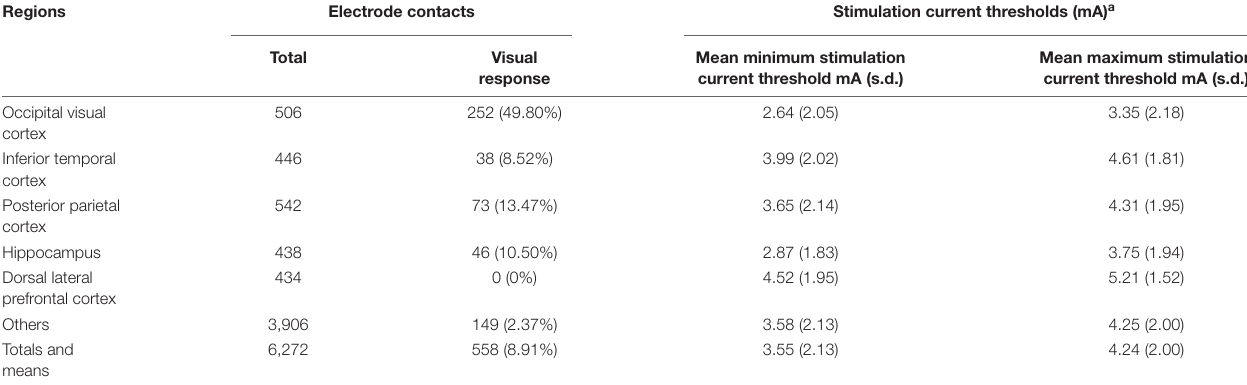
TABLE 1 | Elicitation rates and current